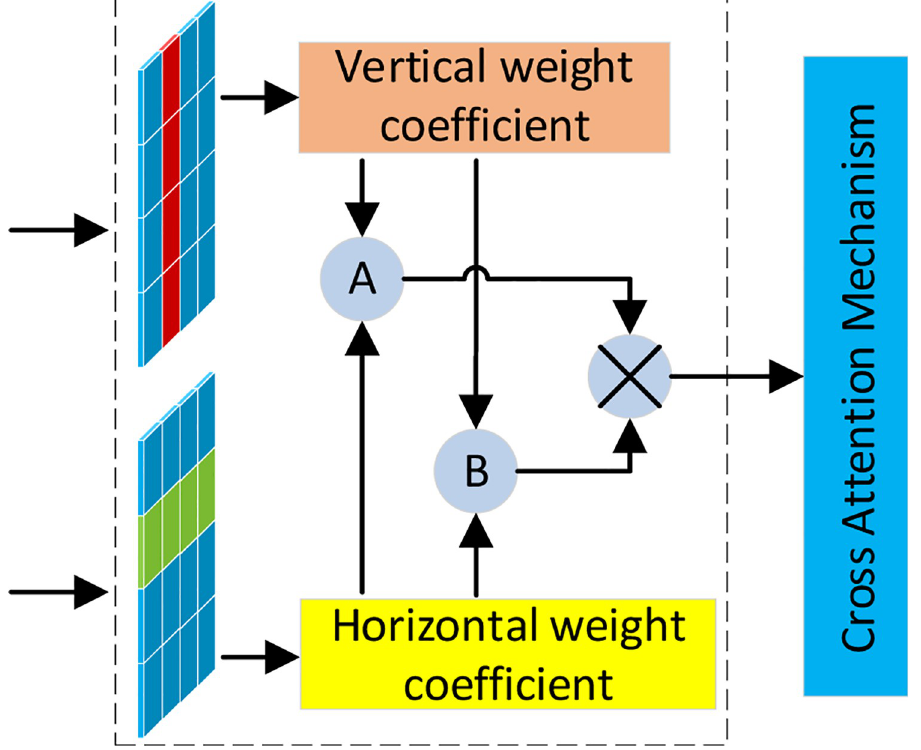
Fig 5. Mechanism of the cross-attention